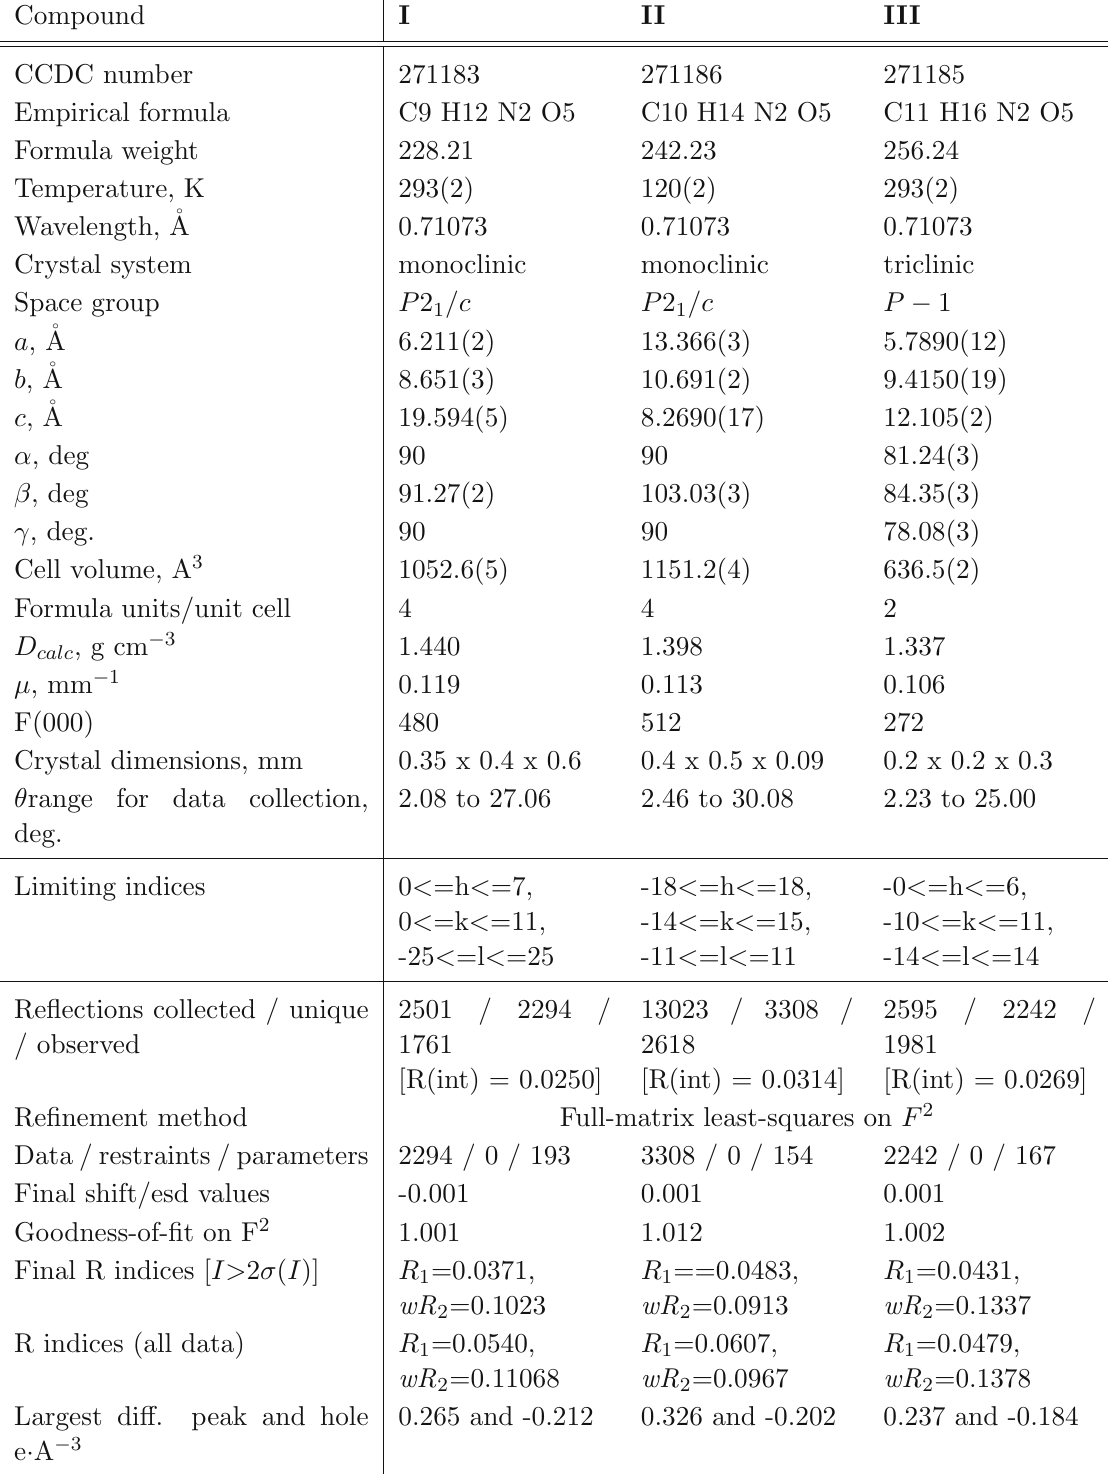
Table 1 Crystal data and summary of intensity data collection and structure refinement for I – VI